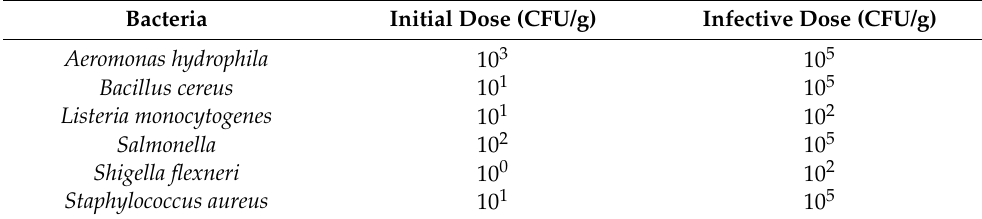
Table 3. Initial and infective doses for each bacterium in study [23].